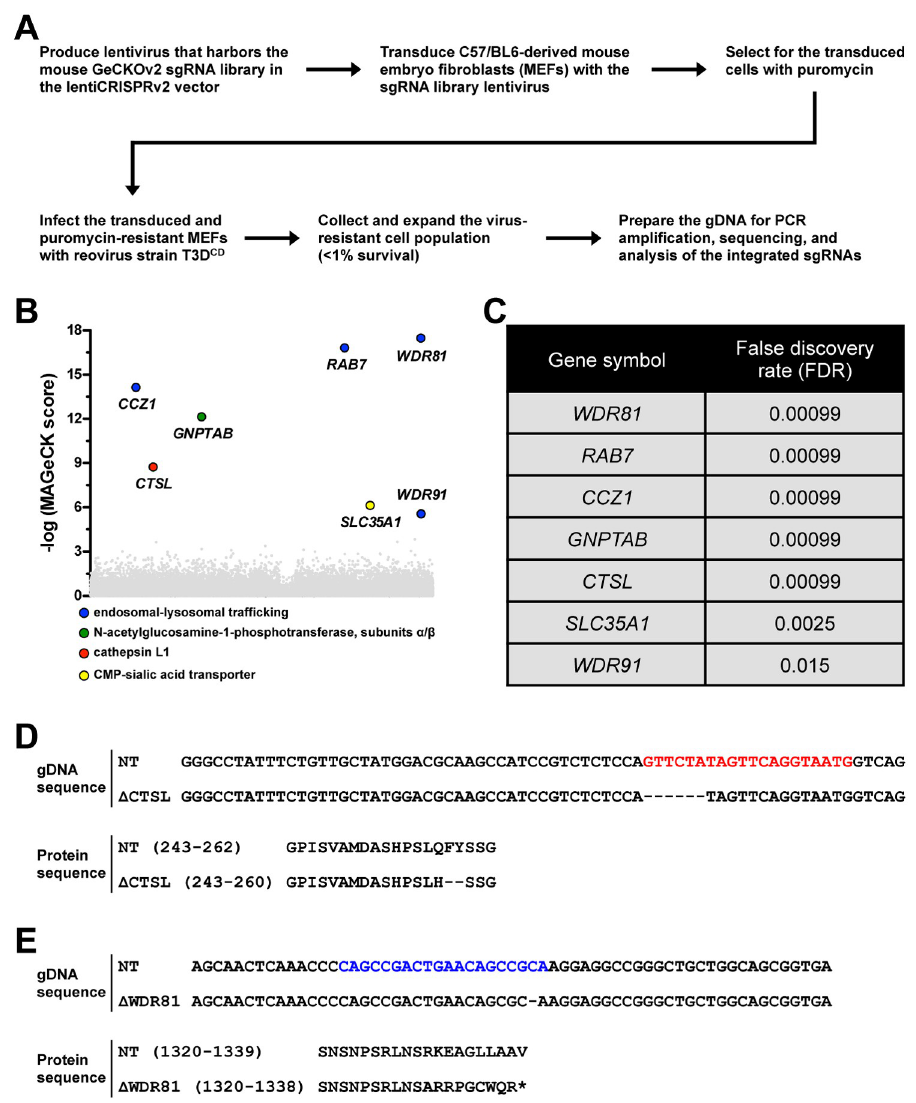
Fig 1. Genome-scale CRISPR-Cas9 knockout screen. (A) Strategy and workflow to identify host factors that are important for reovirus infection. (B and C) Screen results for gene-targeting sgRNAs that were enriched in the virus- resistant cell population. WDR81 sgRNA sequences were highly represented in the recovered clones (n = 2 biological replicates). (D and E) Genomic DNA and protein sequences for CTSL- (D) and WDR81- (E) deficient cell lines. The CTSL- and WDR81-targeting sgRNA sequences are bolded in red and blue,